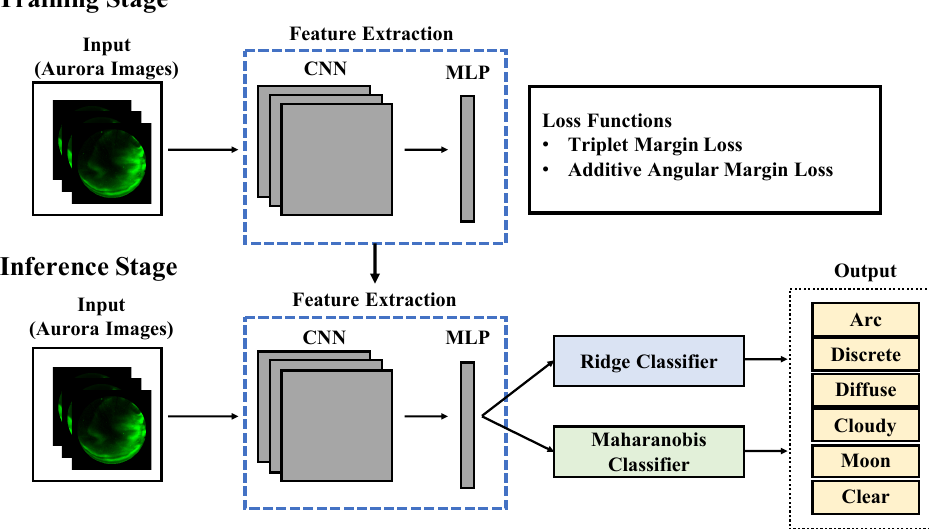
Figure 1. Inference framework for aurora image